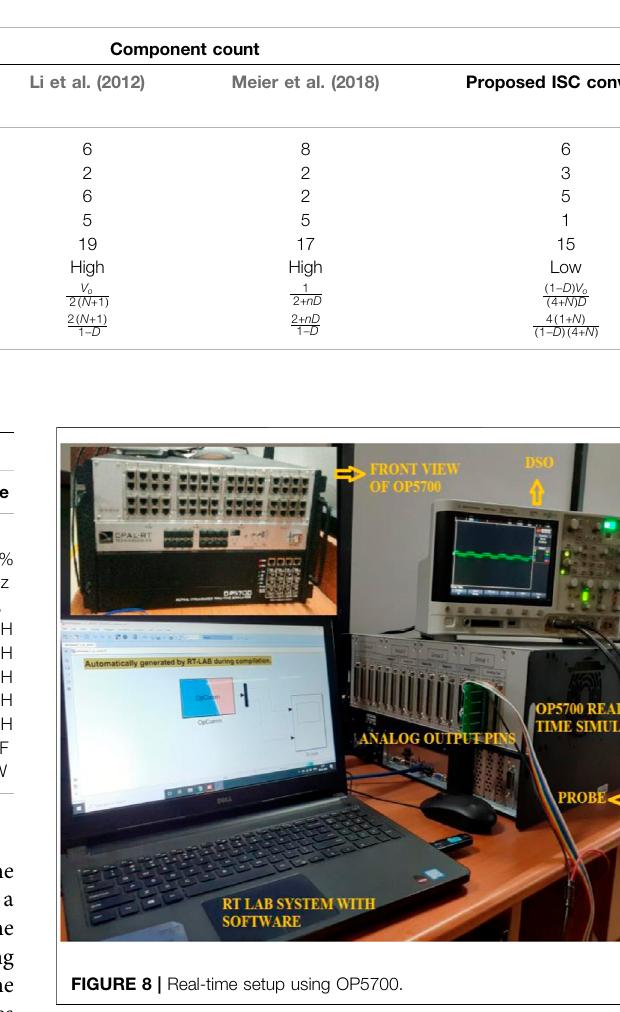
I LC1 is 3.8 A are shown in Figure 13 . The converter ’ s input voltage and the voltage across the diode D 3 Figure 14 . The converter ’ s input current and the voltage across the diode D 4 are shown in Figure 15 . Capacitor voltage and the voltage across the Diode D are shown in Figure 16 . If the duty cycle increases from 0.3 to 0.4, the output voltage rises from 65 V to 145 V. The voltage across the capacitor is as same as the output voltage. The output voltage waveform with a measured voltage of 139 V of the converter and the voltage across the diode D 6 are shown in Figure 17 . The current through the coil I LC2 is 3.6 A shown in Figure 18 . The output current waveform with a measured current of 6.3 A for 40 Ω is shown in Figure 19 .